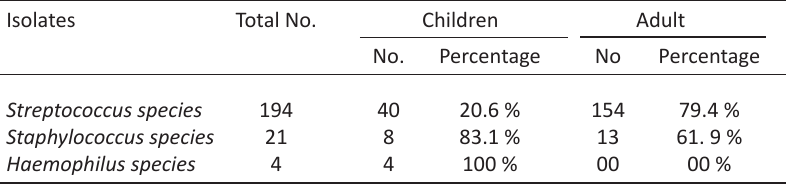
Table 3. Frequency of organisms isolated according to the gender.